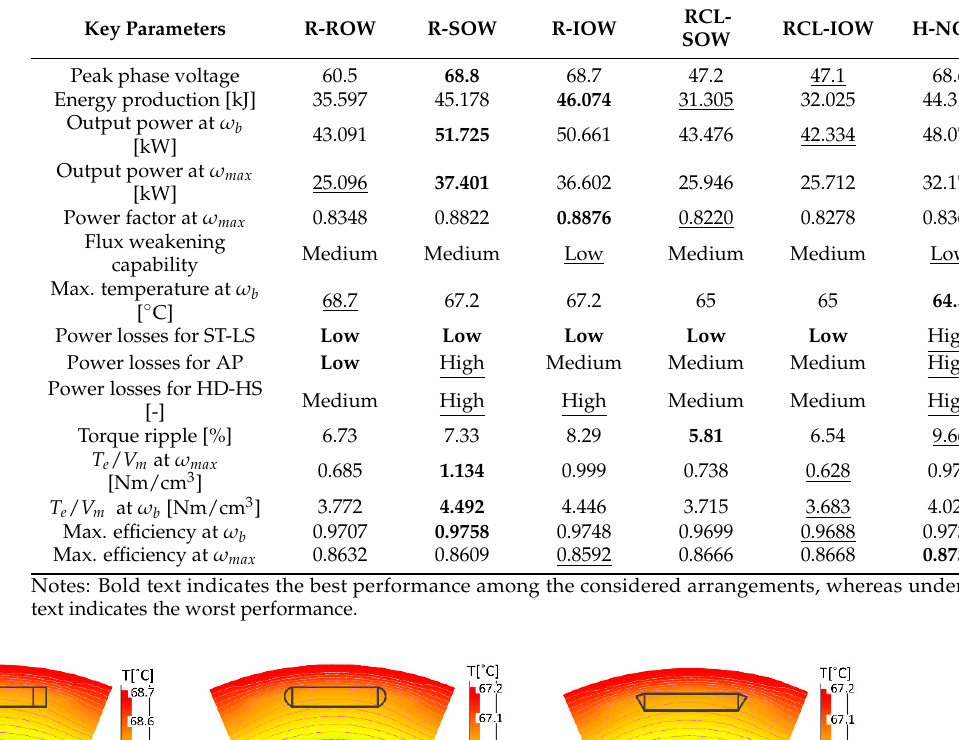
Table 5. Comparative summary of electromagnetic performance of the considered arrangements. Key Parameters